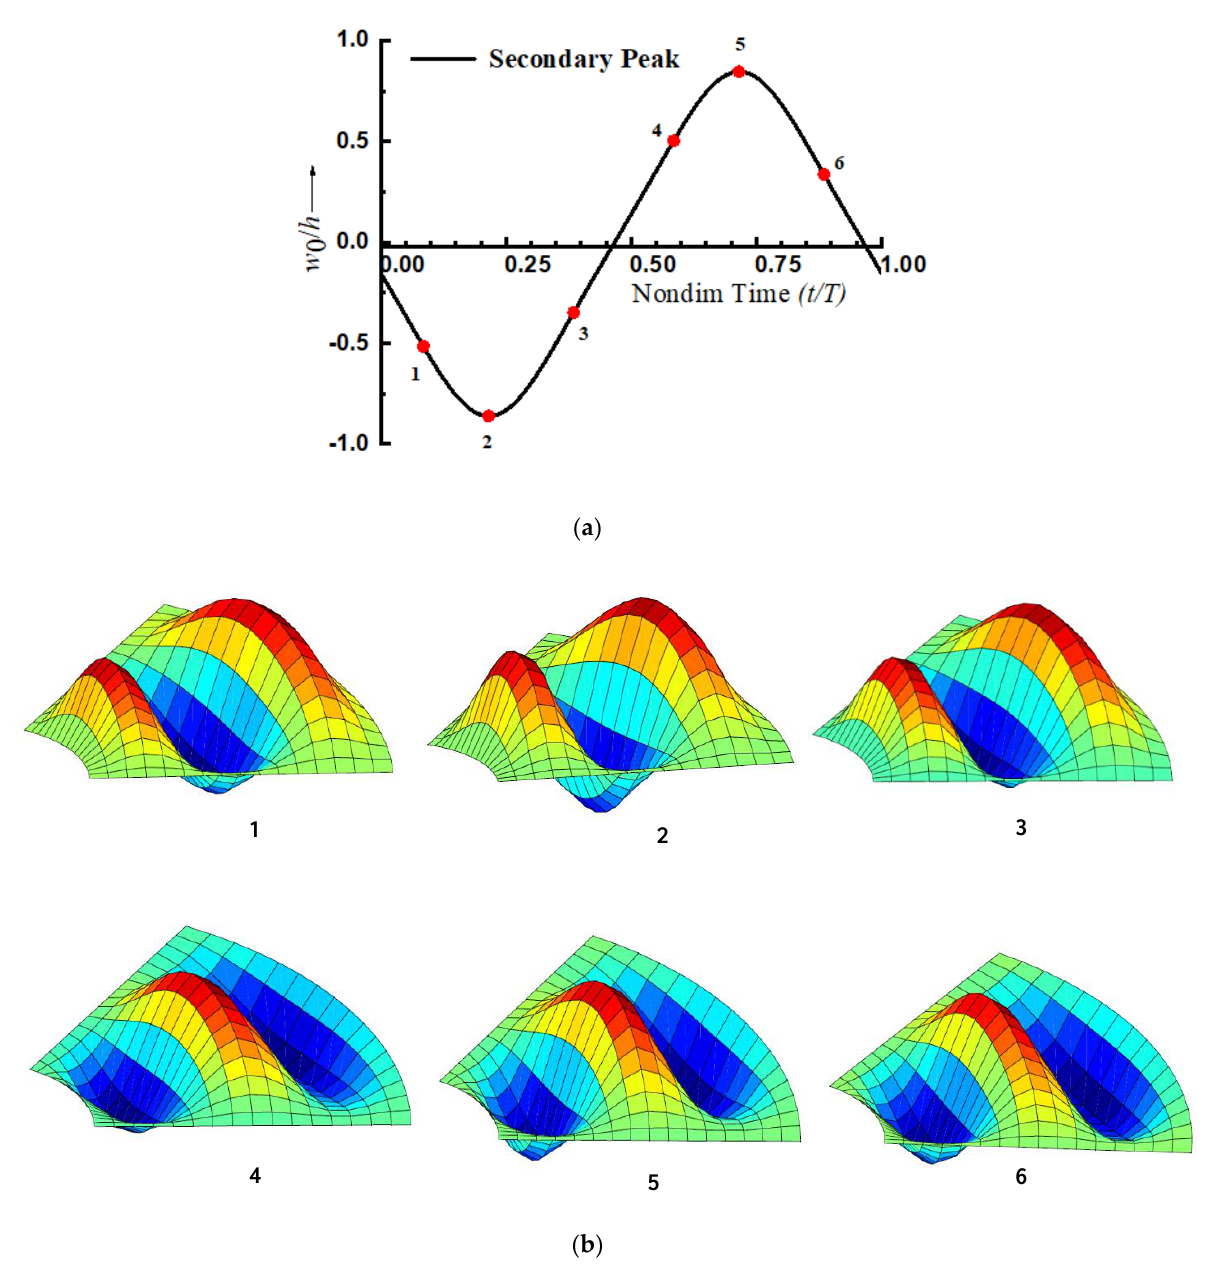
Figure 11. ( a ) Non-linear steady state response corresponding to secondary peak amplitude (Point B) of Figure 6 at the center of the plate for φ = 120 ◦ and ( b ) the corresponding deformed configurations at different instants The effect of the annularity ratio ( r 2 /r 1 ) on the linear and nonlinear forced vibration response is investigated next. The linear and nonlinear peak displacement amplitude corresponding to the variations in forcing frequency ratio for laminated composite annular sector plate with a different annularity ratio ((0 ◦ /90 ◦ ), b 1 / h = 100, φ = 60 ◦ , SSSS, f 0 = 30 Pa, b 1 = 1 m, ζ = 0.01) is presented in Figure 12. It can be inferred from Figure 12 that, with the inclusion of geometric nonlinearity, the frequency response curve reveals hardening nonlinearity for laminated composite annular sector plates and the degree of hardening nonlinearity increases and the peak amplitude grows with a rise in annularity (outer-to-inner radius ratio) for simply supported boundary conditions.